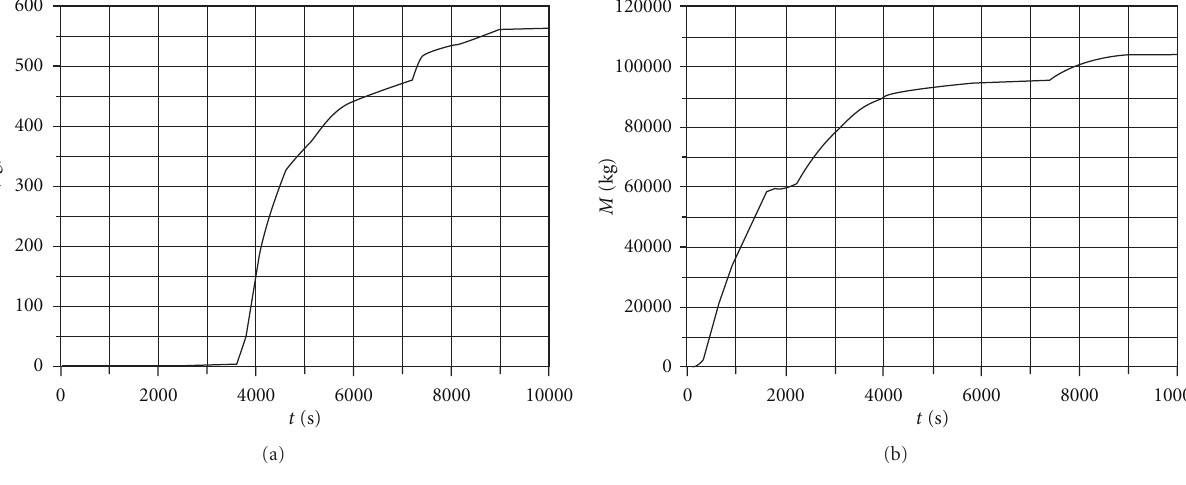
Figure 9: Integral operation (time) of hydrogen (a) and steam